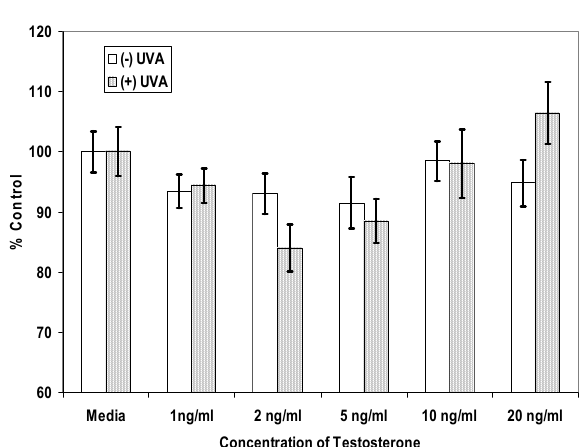
Figure 2: Cell viability of Jurkat T cells at different concentrations of testosterone ±